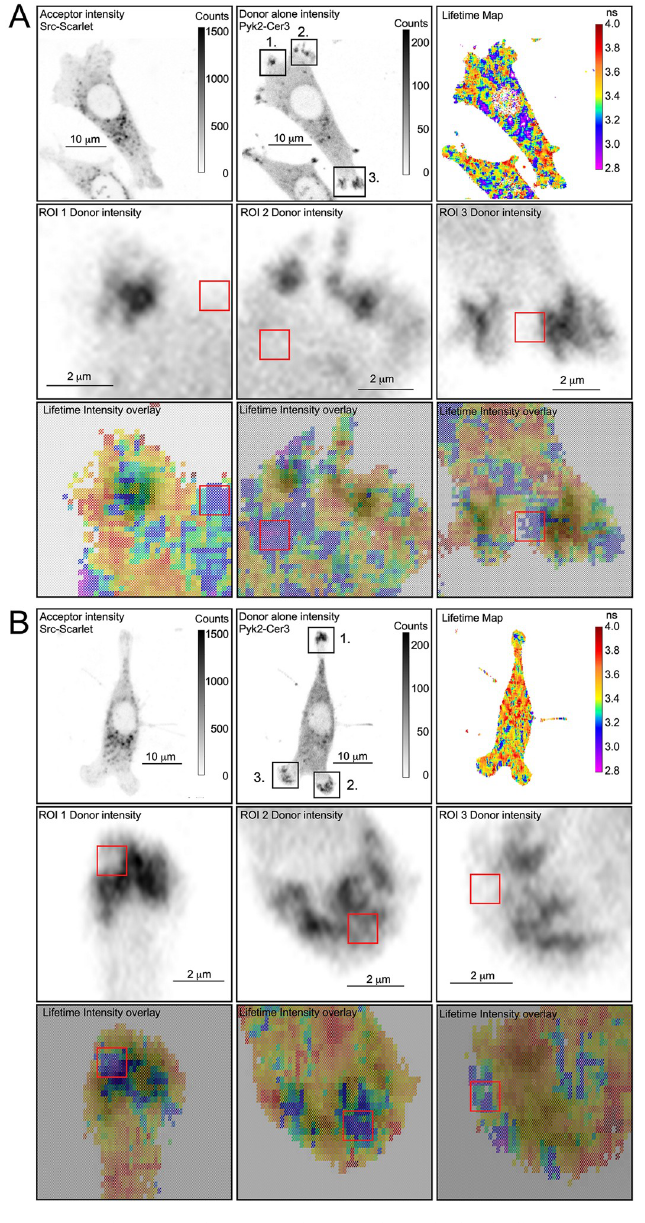
Fig 3. FRET between Pyk2-Cer3 and Src-Scarlet in the focal adhesions in MLO-Y4 cells. Examples of FRET between Pyk2-Cer3 and Src-Scarlet are shown from two representative cells (Panels A and B). Shown are lower and higher magnifications of three different ROI of the cell areas containing focal adhesions, designated 1, 2 and 3 in each of the two cells shown. Of note, the Lifetime maps and IMD overlay at higher magnification show in greater detail the area in and around each of the focal adhesion ROI where FRET between Pyk2-Cer3 and Src-Scarlet are occurring with the highest efficiency (cooler blue and purple colors). Red boxes are included to orient the reader to the position of highest FRET efficiency and highlight that high FRET (cooler colors) is occurring outside of the area of the FA with the highest donor intensity.